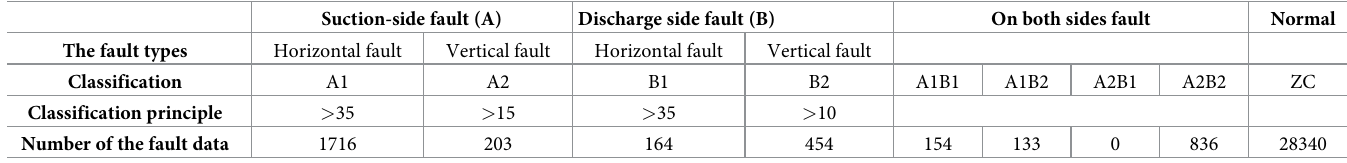
Table 1. Original data classification